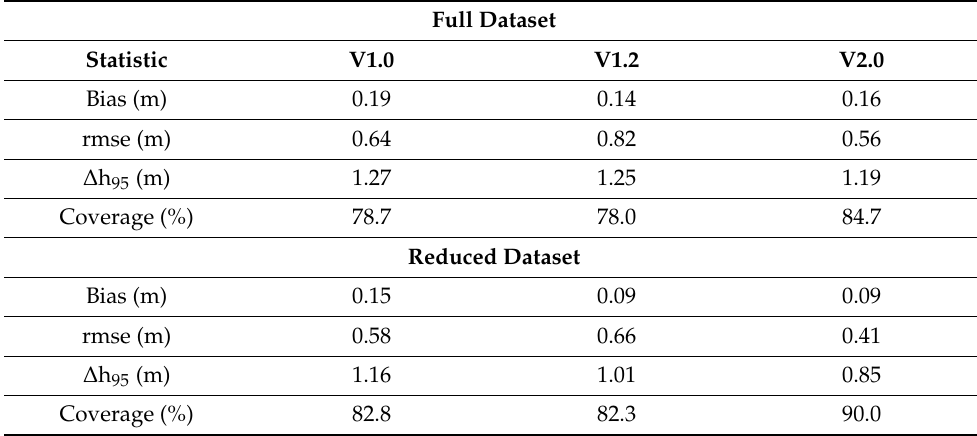
Table 1. Means of the four basic performance statistics (rows) comparing across the three versions of the cBathy algorithm (columns). Statistics are computed for the full dataset of 624 runs (upper section) as well as for the reduced dataset of 563 runs for which successful coverage was greater than 50% (based on V2.0 coverage) and significant wave height was less than 1.2 m (lower section). Full Dataset Statistic